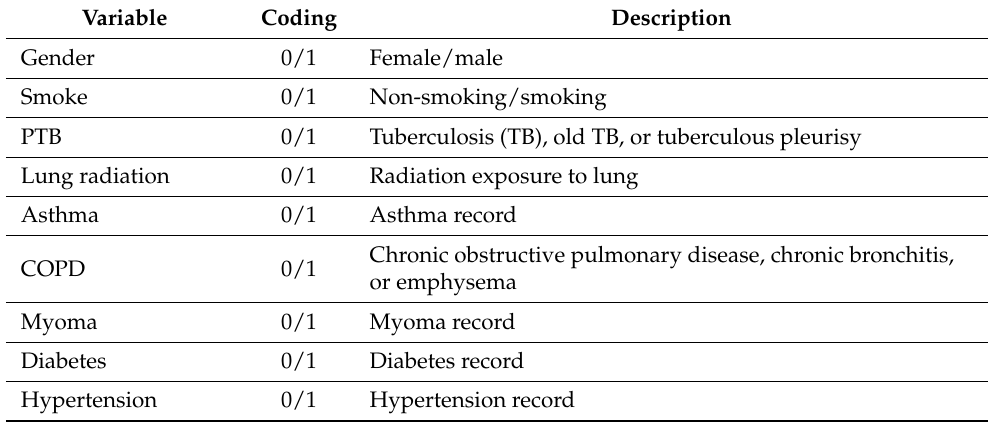
Table 1. The 26 investigated variables from health examinations, including physical examinations, medical history, family history of lung cancer, and blood tests. Of these, 18 binary variables were coded as 0/1 for No/Yes or female/male. The other eight continuous variables were from blood test